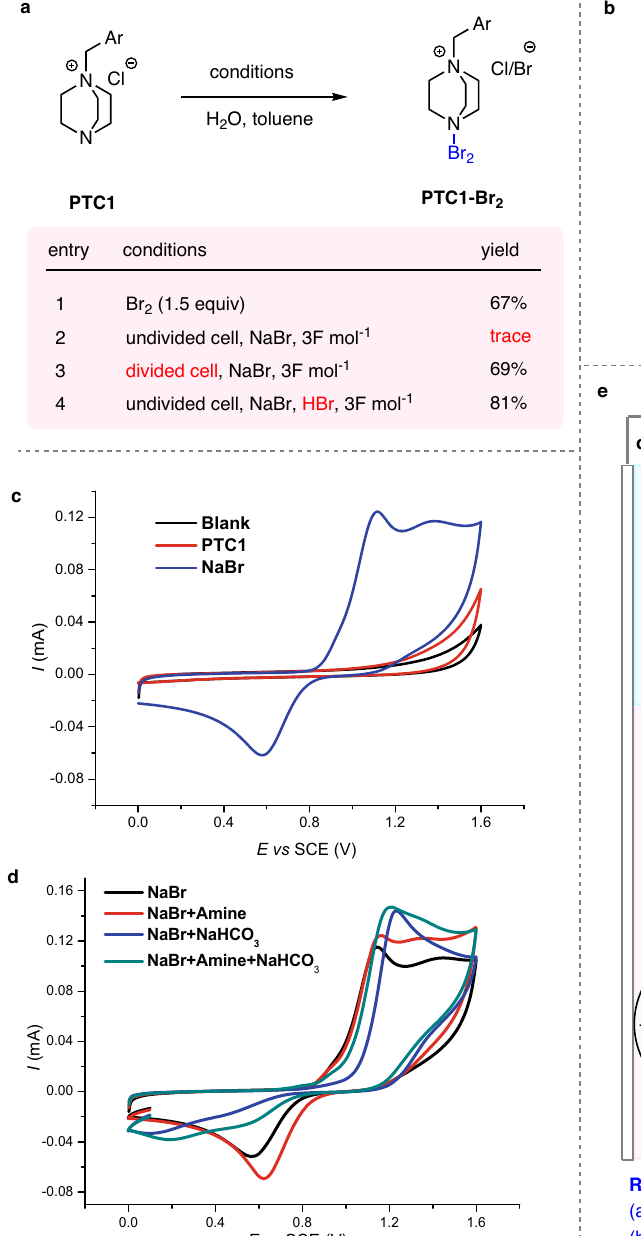
Fig.4 |Mechanisticstudyandproposedmechanism.a Comparisonofthe PTC1- Br 2 intermediate formation conditions. Ar=3,5-bis(tri fl uoromethyl)phenyl. b Effect of NaHCO 3 and NaOH in the bromination process using preformed PTC1- Br 2 as a stoichiometric reagent. When NaOH was used, no conversion of 1a was observed because it decomposed PTC1-Br 2 . In contrast, NaHCO 3 prevented this